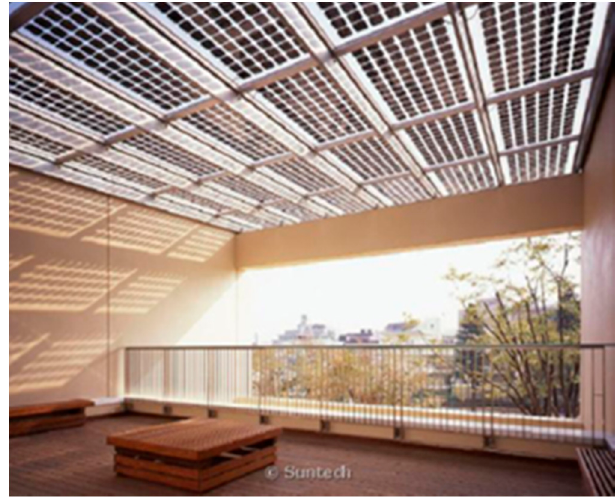
Figure 11. Glass ceiling with transparent BIPV modules [145].